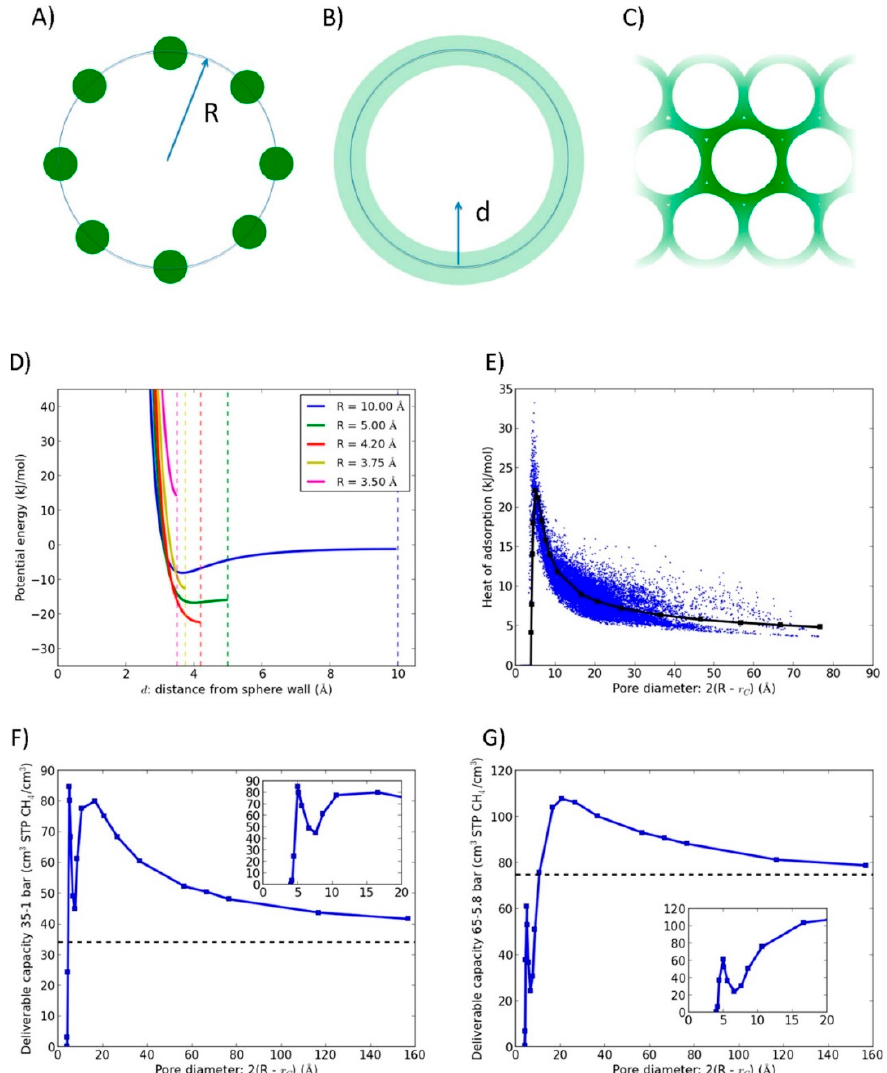
Figure 3. ( A ) Model of pore surface consisting of a sphere of atoms, uniformly distributed. ( B ) Model with smeared atoms forming a spherical shell with radius R. ( C ) Hexagonally close-packed unit cell consisting of spherical pores. ( D ) Potential energy of CH 4 as a function of distance from sphere wall for this model. ( E ) The simulated heat of adsorption (kJ / mol) of CH 4 as a function of pore diameter. ( F , G ) Deliverable CH 4 capacity as a function of pore diameter. Calculations were completed between 1 and 35 bar and 65 and 5 bar. Dashed line is the deliverable capacity of a free space tank assuming pressure equals fugacity, as assumed in this sphere model analysis. Adapted with permission from Ref. [65]. Copyright 2014 American Chemical Society.